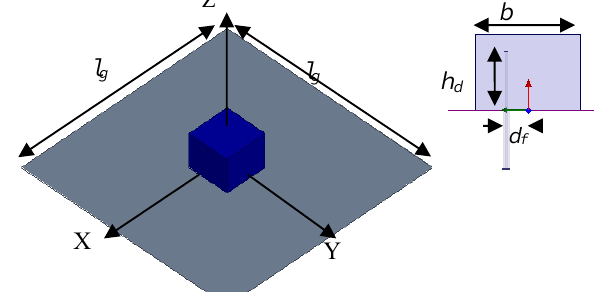
Figure 1: The structure of square DRA element.